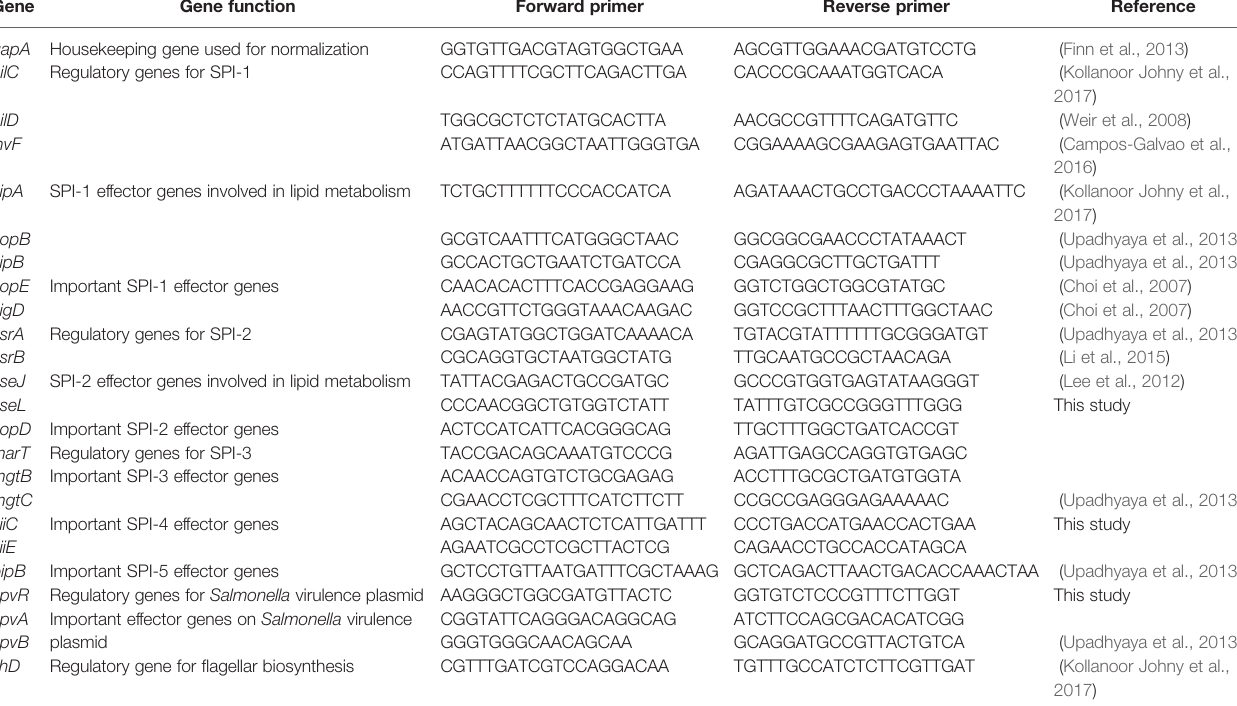
TABLE 2 | Primers used for RT-qPCR to detect the expression of virulence genes of Salmonella Enteritidis grown in egg yolk and tryptic soy